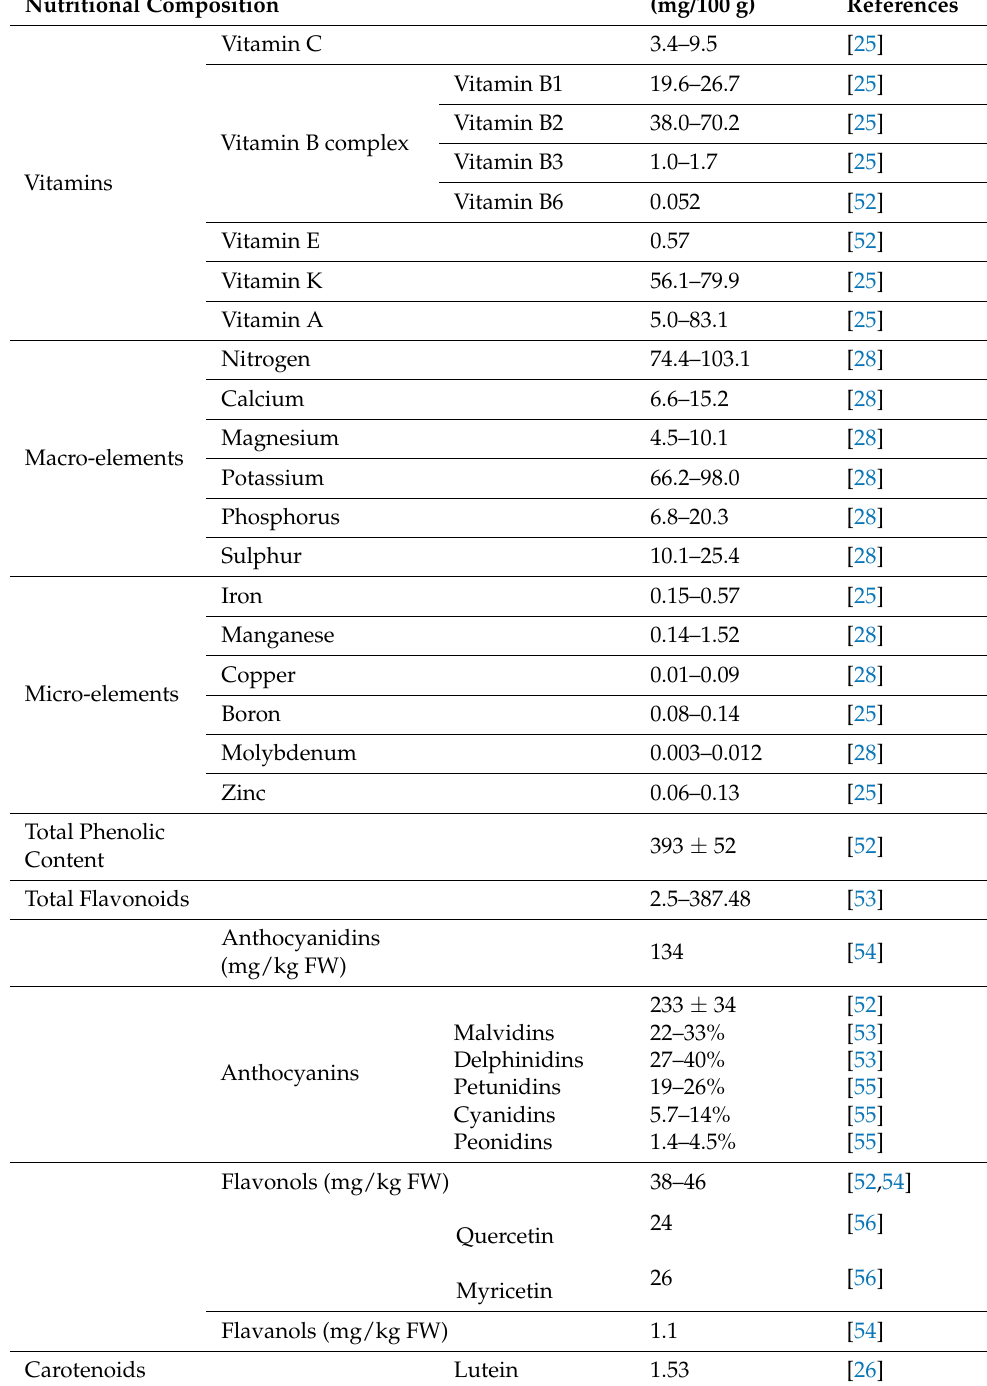
Table 1. Bioactive constituents of blueberry